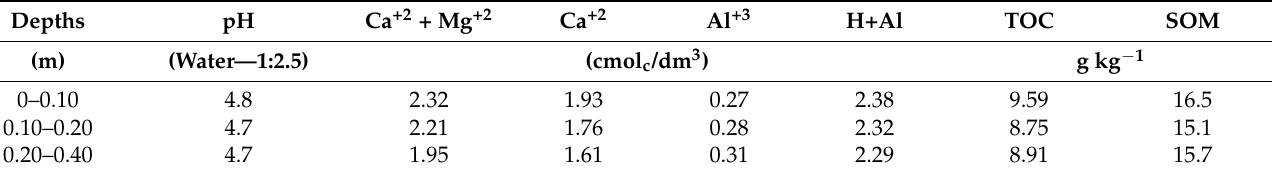
Table 1. Soil chemical characteristics of the experimental area at different